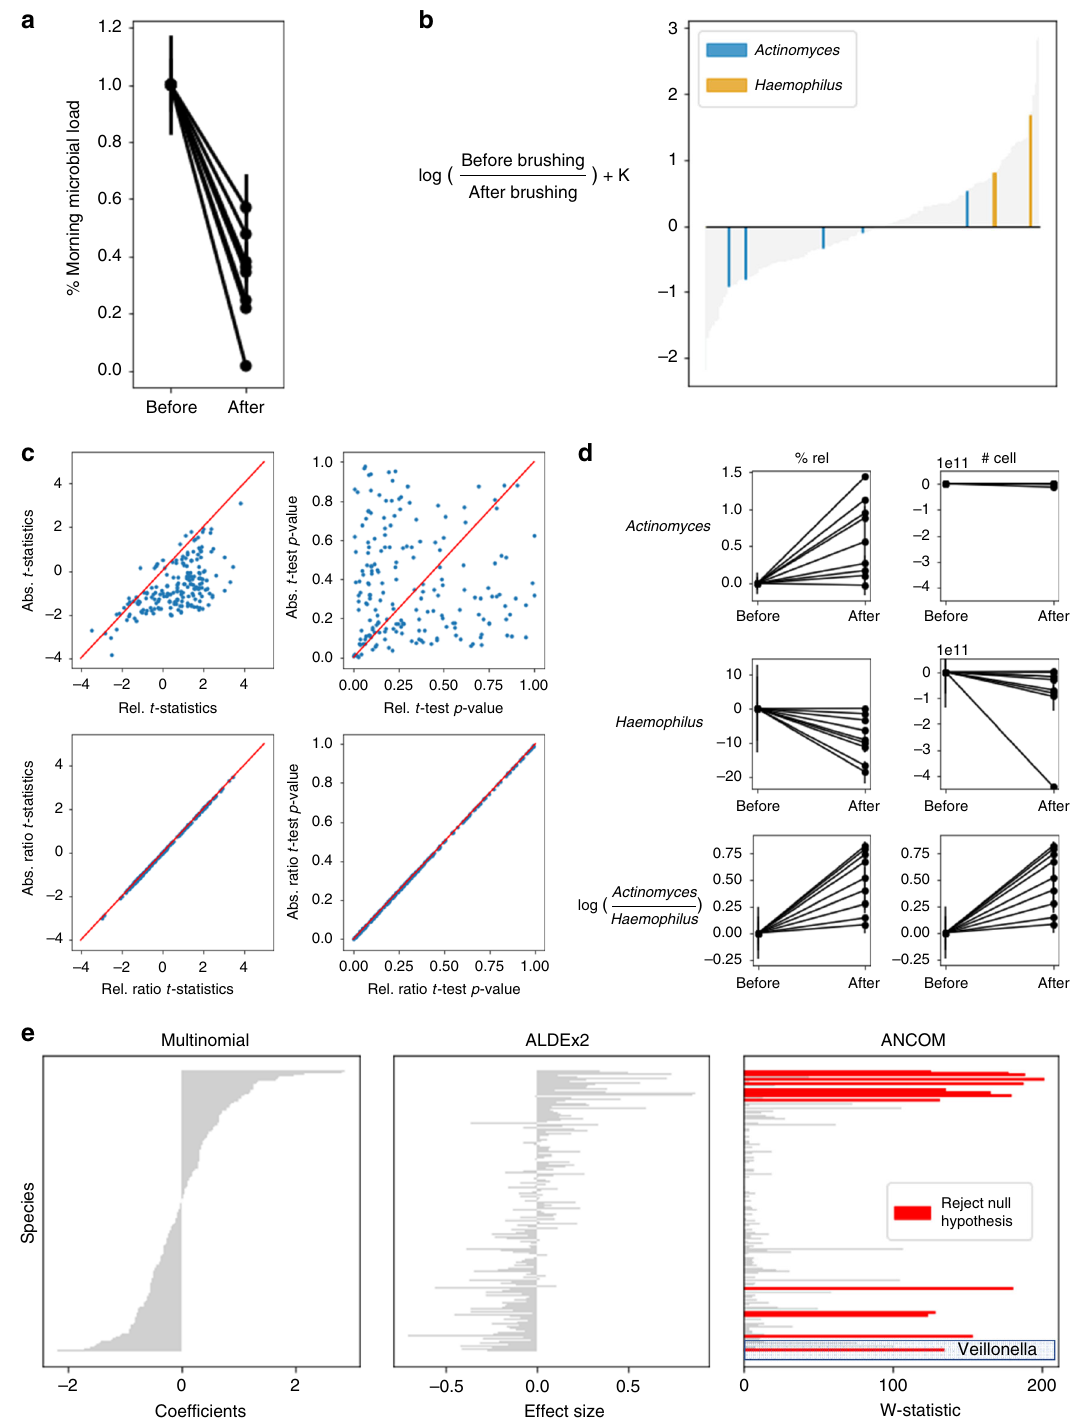
Fig. 2 Analysis of salivary microbiota before and after brushing teeth. a Flow-cytometry-quanti fi ed microbial load in unstimulated saliva collected for 5 min normalized to before brushing teeth. Each line corresponds to a different volunteer. Error bars represent the standard deviation from duplicate fl ow- cytometry measurements. b Microbial ranks estimated from multinomial regression with Actinomyces and Haemophilus highlighted. The y -axis represents the log-fold change that is known up to some bias constant K, and the x -axis numerically orders the ranks of each taxa in the analysis. c A comparison of t - statistics (left) and p -values (right) between before and after samples where each dot is an individual taxon (top graphs) or ratio between each taxon to Actinomyces (bottom graphs) calculated from relative abundance data ( x -axis) and absolute abundance data ( y -axis). The 1-1 correspondence in the ratio graphs is a result of the microbial loads cancelling out, as described in Eq. (3). d A comparison of relative abundance vs absolute abundance data of Actinomyces , Haemophilus and log( Actinomyces: Haemophilus ) before and after brushing teeth. Error bars represent standard error of the mean. e Comparison of the multinomial coef fi cients used for DR, ALDEx2 and ANCOM outputs. The test statistics generated from ALDEx2 and ANCOM are sorted in the same order as the multinomial coef fi cients to provide a consistent comparison. All taxa that passed the signi fi cance tests are highlighted in